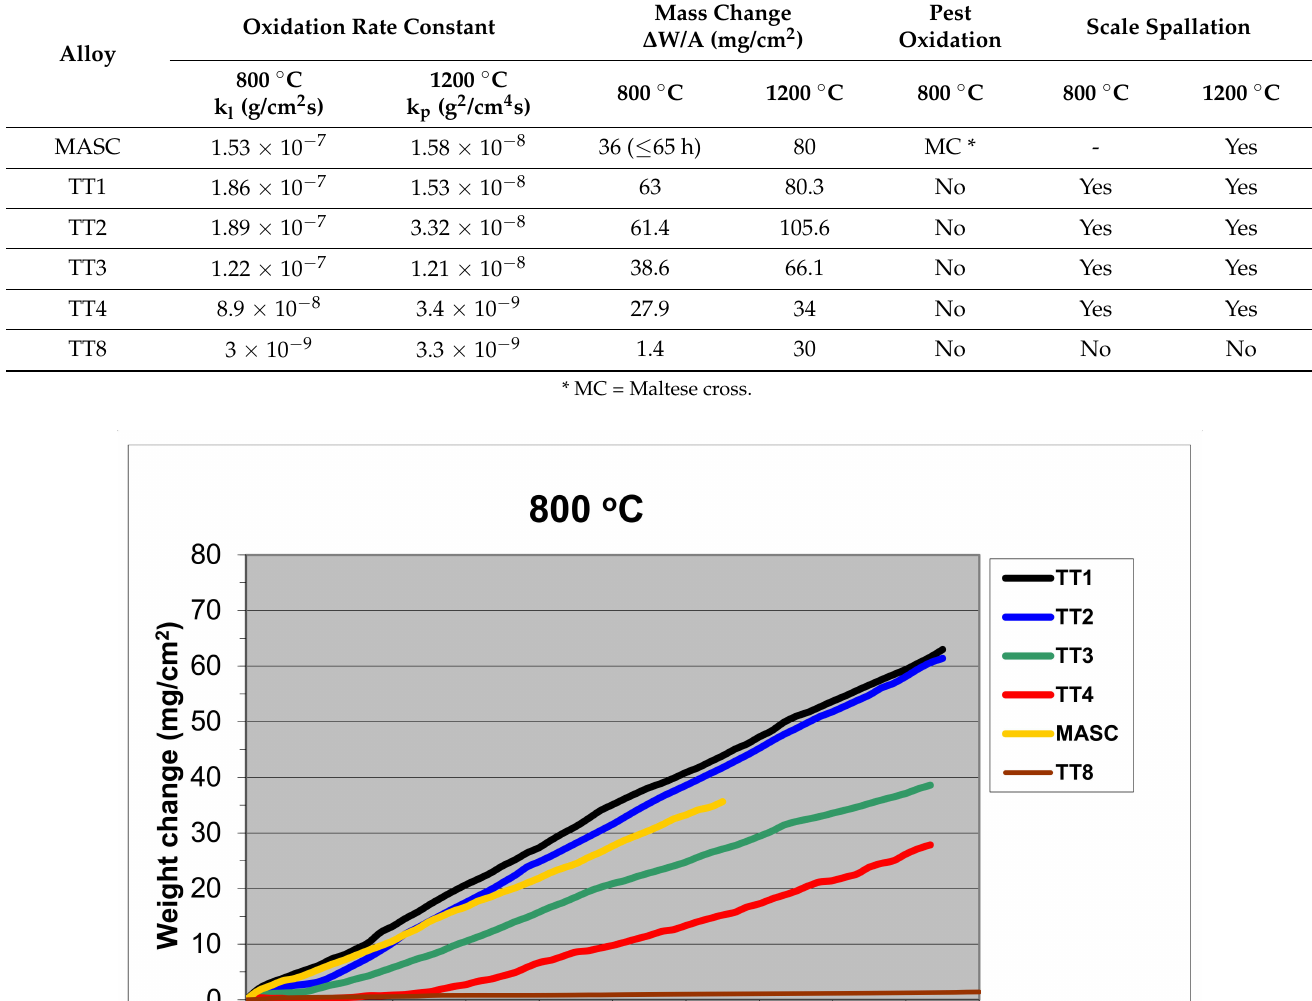
Table 6. Oxidation rate constants and mass changes of the alloys after isothermal oxidation for 100 h at 800 and 1200 ◦ C. Oxidation Rate Constant Alloy